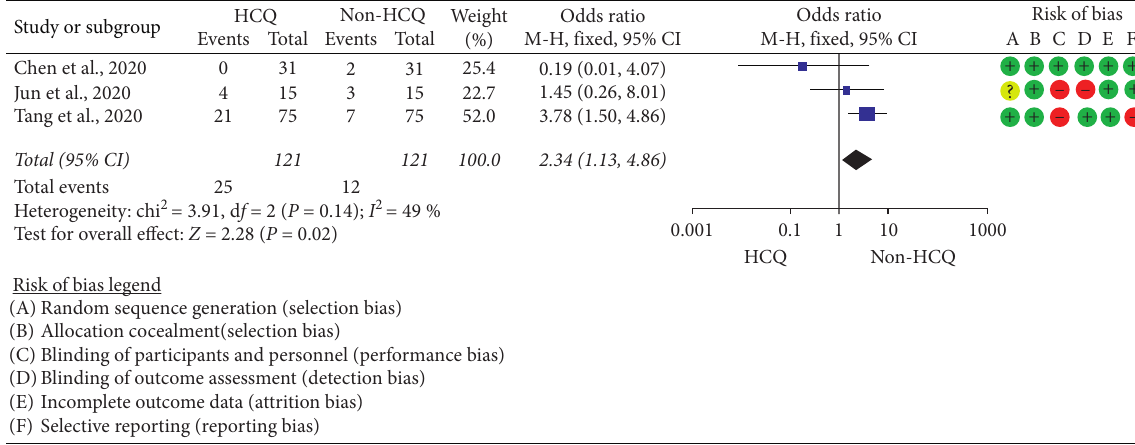
Figure 6: Safety of HCQ as compared to non-HCQ (standard care) among COVID-19 patients.